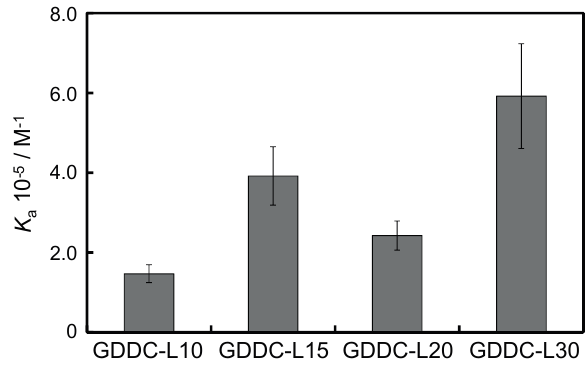
Figure 7. K a values of CuAPC for GDDC with various loop lengths (10 to 30 bases). All measurements were carried out in 50 mM MES-LiOH (pH 7.0), 100 mM KCl, 10 mM MgCl 2 buffer at 25